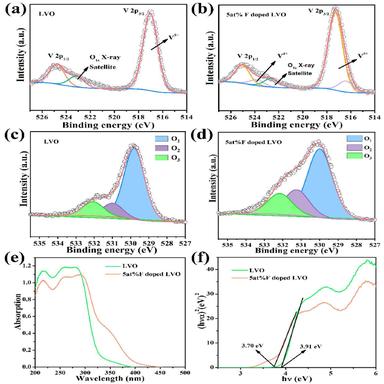
Core level V 2p spectra for (a) undoped and (b) 5 at% F doped samples; core level O 1s spectra for (c) undoped and (d) 5 at% F doped samples; and comparisons of (e) UVvis spectra and (f) the corresponding tauc's plots for undoped and 5 at% F doped samples.